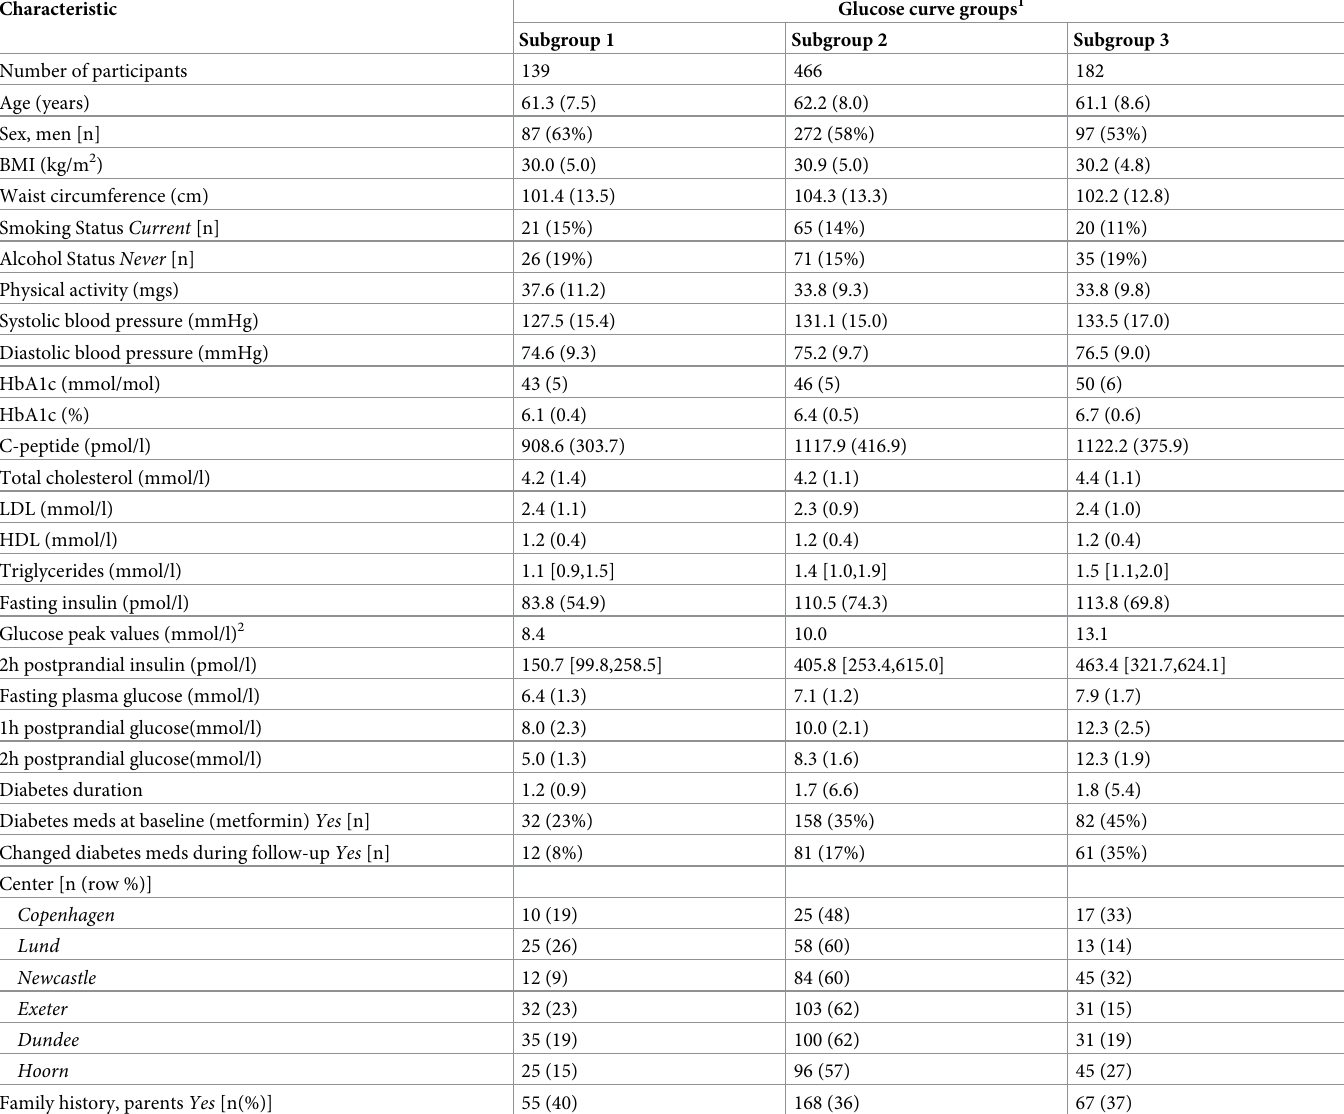
Table 1. Characteristics of 787 individuals with type 2 diabetes stratified by glucose curve